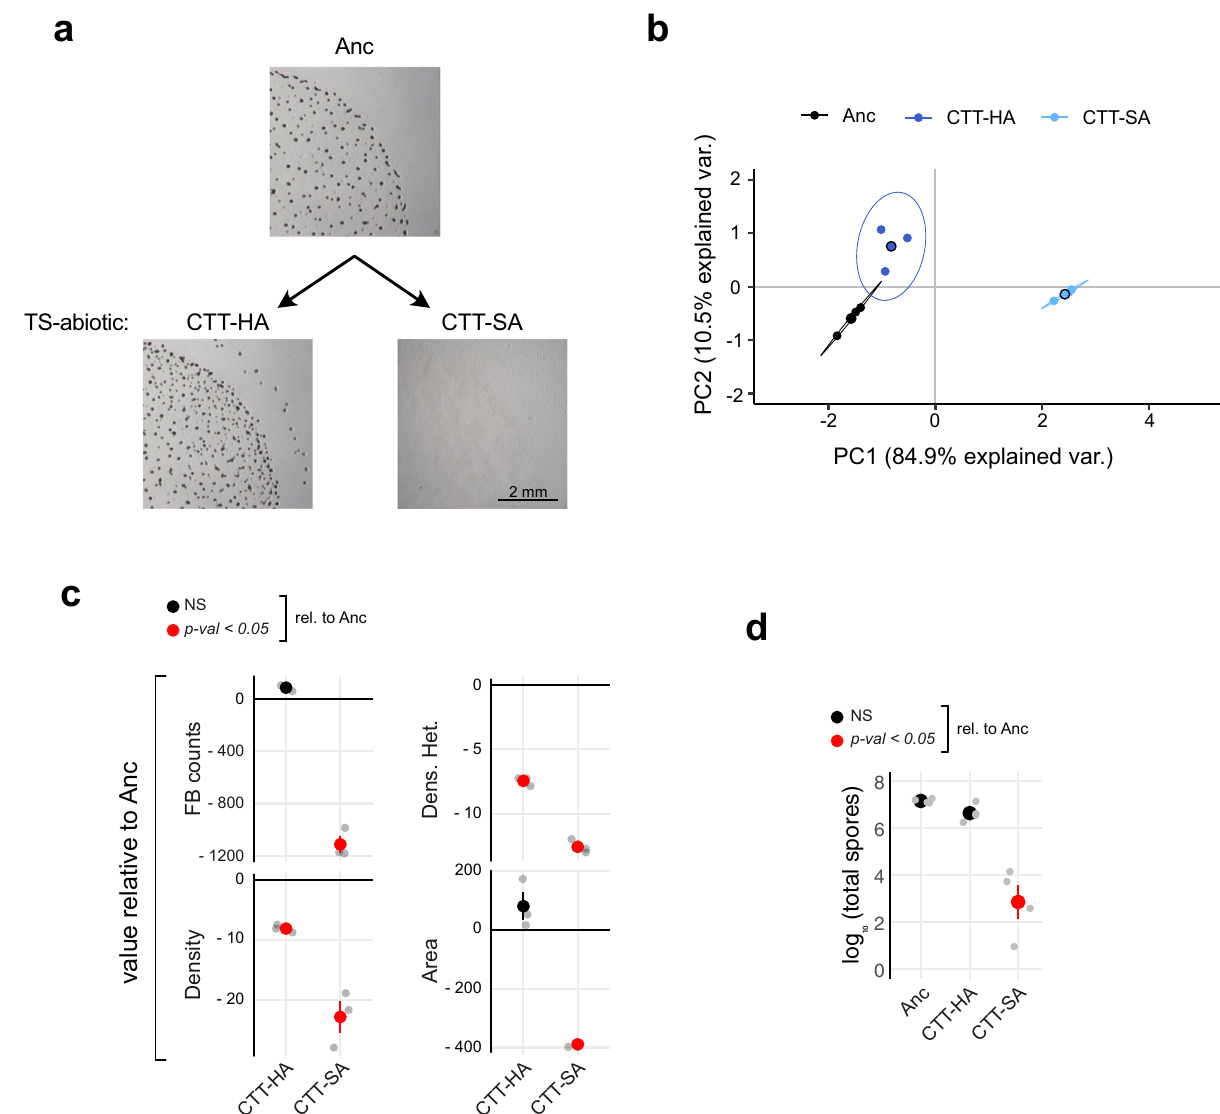
Fig. 2 Surface stiffness shapes developmental LPE. a Representative developmental phenotypes of the ancestor (Anc) and TS-abiotic evolved populations from CTT-HA (Population 3, P3; see Supp. Table 1) and CTT-SA (P39) (scale bar = 2 mm). b PCA based on four morphological traits showing the overall treatment-level phenotypic differentiation among the CTT-HA (dark blue) and CTT-SA (light blue) TS-abiotic treatments (MyxoEE-3 cycle 40) and their ancestor (black). Large circles represent average morphospace localization (centroids) obtained from three independent biological replicates (small circles, n = 3). Ellipses represent 95% con fi dence regions, while percentage values on the x and y axis report the variation explained by the principal components PC1 and PC2, respectively (Supp. Fig. 1A). c Mean values ± SEM of each analyzed morphological trait relative to the ancestral levels (Anc, black-horizontal line in the graphs) ( n = 3). d Mean values± SEM of log 10 -transformed spore counts ( n = 4). In both c and d , red and black circles indicate signi fi cant ( p < 0.05) and non-signi fi cant (NS) differences from Anc levels, respectively. (Signi fi cance was estimated for both c and d with one-way ANOVA followed by two-tailed Tukey tests. p values of all comparisons of evolved treatments with Anc, as well as all pairwise comparisons between evolved treatments, are reported in Data Fig. fi rst, microscopic observation (Fig. 2a), PCA of the entire Substrate stiffness determines the character of developmental morphological-trait data set (Fig. 2b) and individual-trait analysis LPE . We quantitatively compared the LPE of fruiting body mor- (Fig. 2c, d) collectively indicate that both TS-abiotic treatments phology across MyxoEE-3 populations from both the TS-abiotic diverged morphologically from the ancestor but did so in a and TS-biotic treatment sets and the ancestor (Anc). To do so, we treatment-speci fi c manner. Indeed, perMANOVA of PCA values used previously published methods of quantifying four morpho- demonstrates morphological differentiation between the lines logical fruiting body traits 11 : three trait medians measured at the evolved on soft agar (CTT-SA) vs on hard agar (CTT-HA) (per- resolution of individual fruiting bodies (density, density hetero- MANOVA: F = 42.9, R2 = 0.94, P = 0.005). geneity, and area) and total fruiting body number per assay plate PC1 explained 85% of the total variance (Supp. Fig. 1a), with all (see Methods: Induction of development and Image acquisition analyzed traits making similar contributions to shaping the and trait quanti fi cation; also ref. 11 ). Considering TS-abiotic fruiting body morphospace and showing strong correlations with